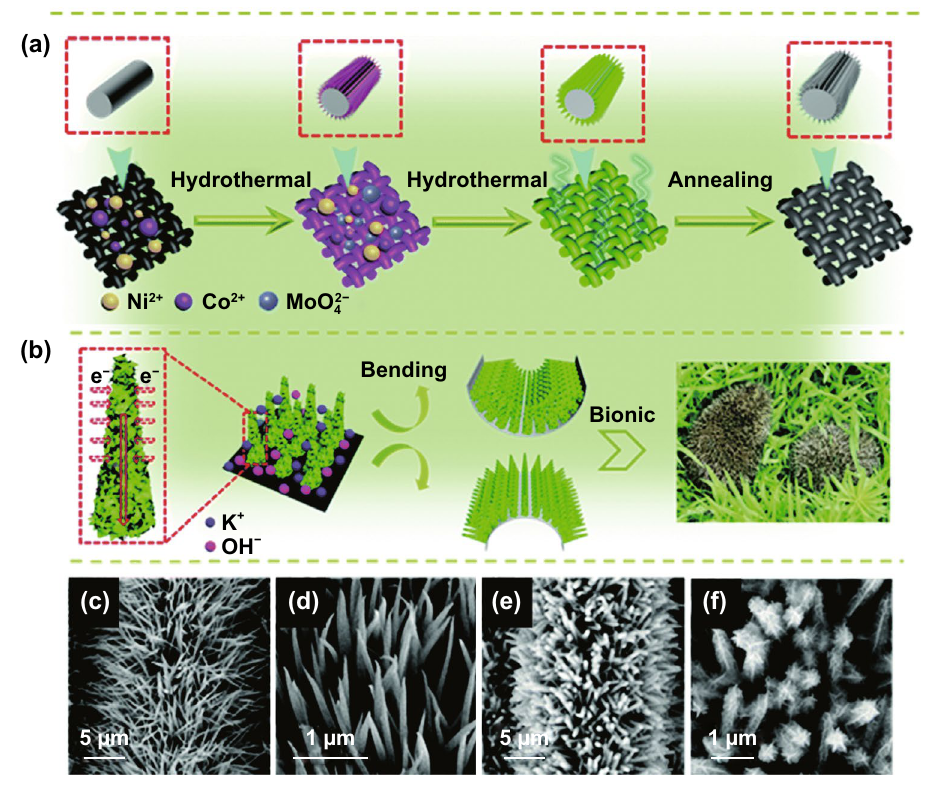
Fig. 5 a Schematic illustrations of NiCo 2 O 4 @Ni x Co y MoO 4 nanostructures (carbon fabric (black), NiCo 2 O 4 nanoneedle clusters (pink), the